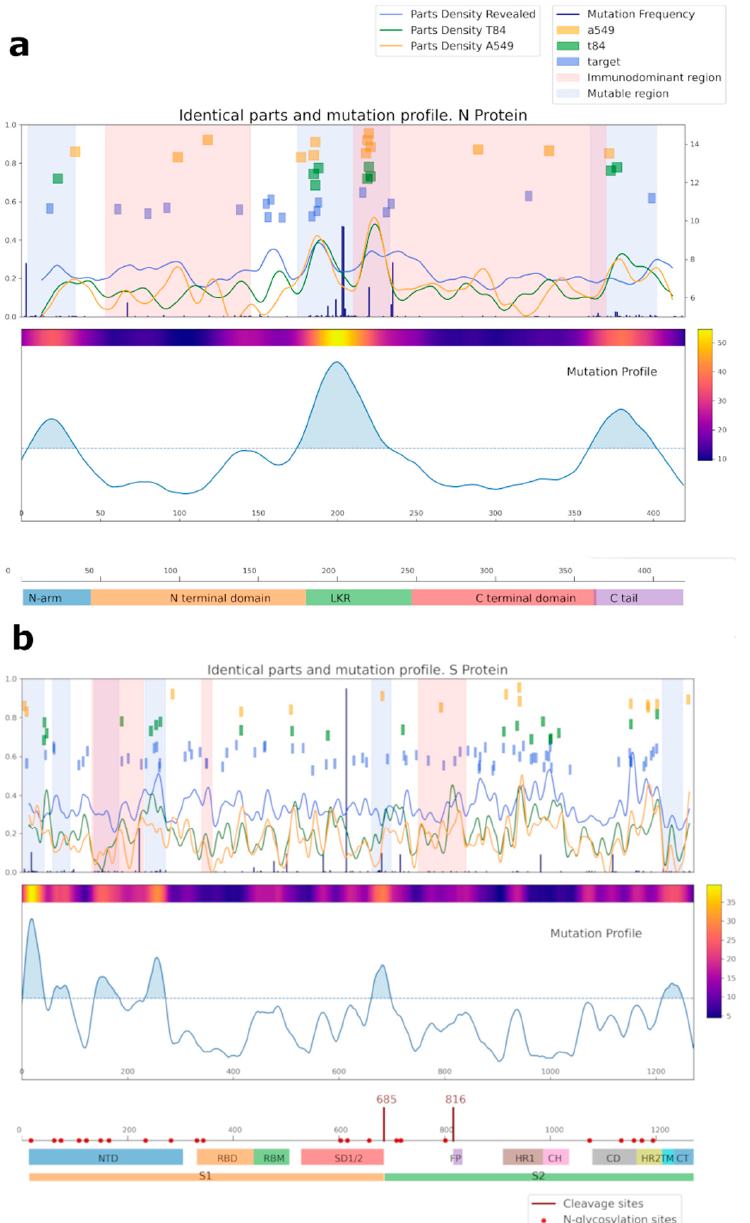
Figure 6. Analysis of the common regions between N ( a ), S ( b ) SARS-CoV-2, and human proteins. Proteins from the A549 cell line are shown in yellow; proteins from the T84 cell line are in green; our target protein, detected by mass-spectrometry as potentially capable of being recognized by IgG antibodies, is in blue. For cell lines, the intersection area was selected at 6 amino acids; for target proteins, it was selected at 4. Mutational and immunodominant profiles of proteins were taken from published